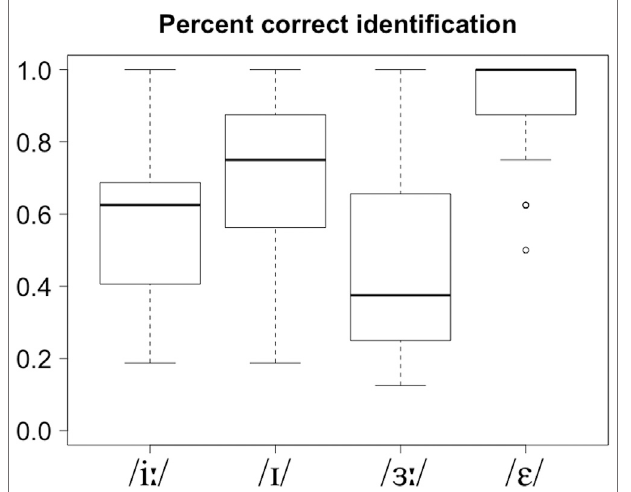
FIGURE 2 | Boxplots of discrimination accuracy for the two English vowel contrasts examined. Boxplots represent the quartile ranges of the scores (top of box: 75th percentile, bottom of box; 25th percentile; line in the middle: median). The whiskers represent the highest and lowest values that are not outliers or extreme values, which are indicated by circles outside the